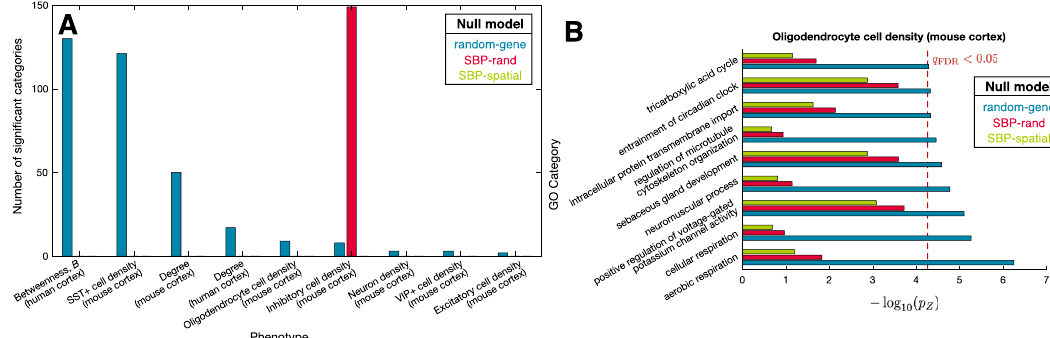
Fig. 5 GO category enrichment results depend strongly on the null ensemble. A Across the range of structural connectome nodal metrics (mouse and human) and cell density phenotypes (mouse), we show those nine phenotypes that individually exhibited categories with signi fi cant enrichment according to at least one of the null models. In all but one case, enrichment under the random-gene null is not signi fi cant under either of the random-phenotype nulls. B Picking an example enrichment analysis — oligodendrocyte cell density, which has nine signi fi cant categories under the random-gene null — we plot the variation in estimated p values (uncorrected) across the three null models (estimated from a Gaussian fi t to the null distribution as p Z ). The corrected signi fi cance threshold, q FDR = 0.05, for the random-gene null is shown as a dashed red line; bars to the right of this line are considered signi fi cant at a